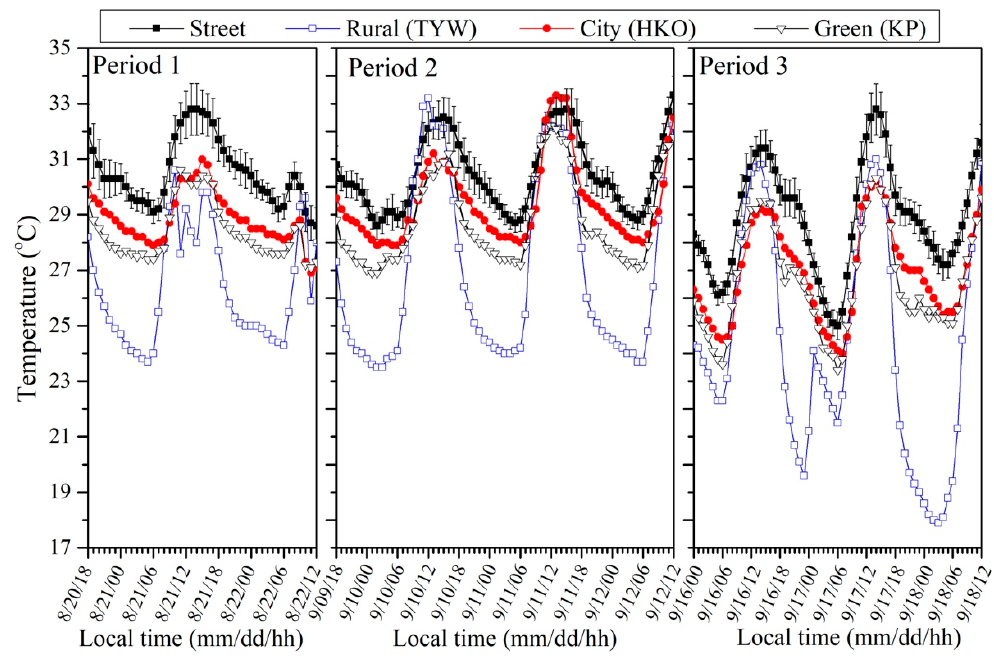
Figure 11. The hourly average temperature in the street and three fix stations.